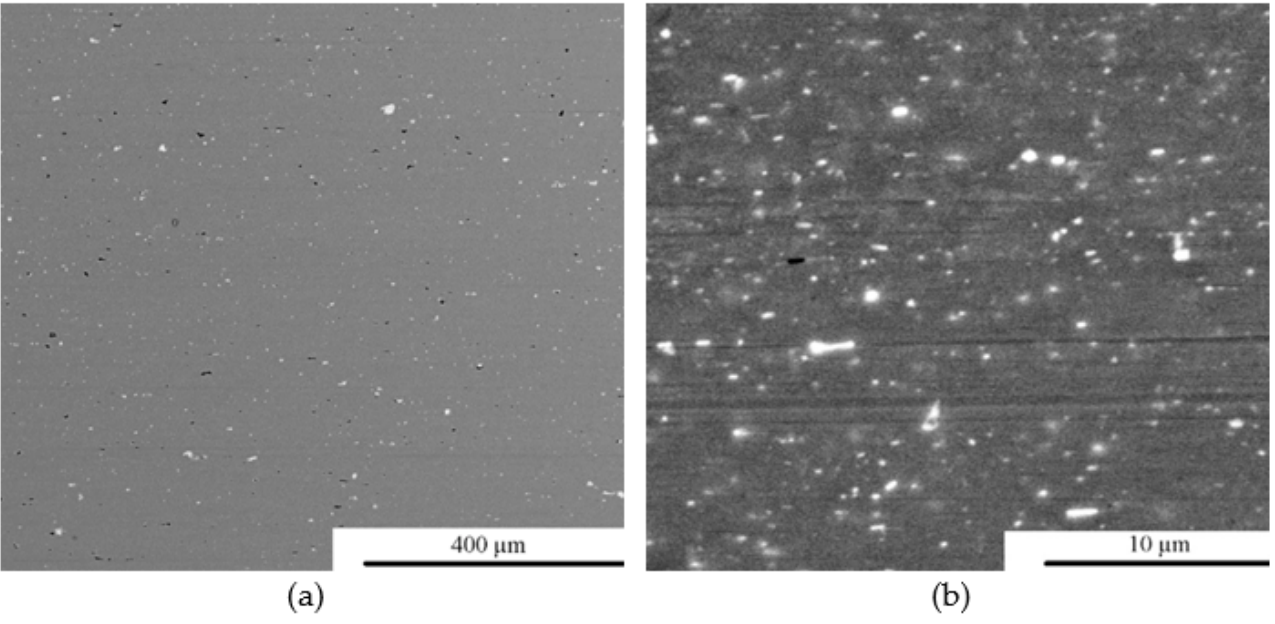
Figure 7. The AlMg 6 Mn 0.7 (1565 ch) particles after cold deformation, sheet thickness 5 mm: ( a ) intermetallic compounds; ( b ) dispersoids. Table 4. Dimensions and volume fraction of intermetallic compounds in the AlMg 6 Mn 0,7 (1565ch) alloy.